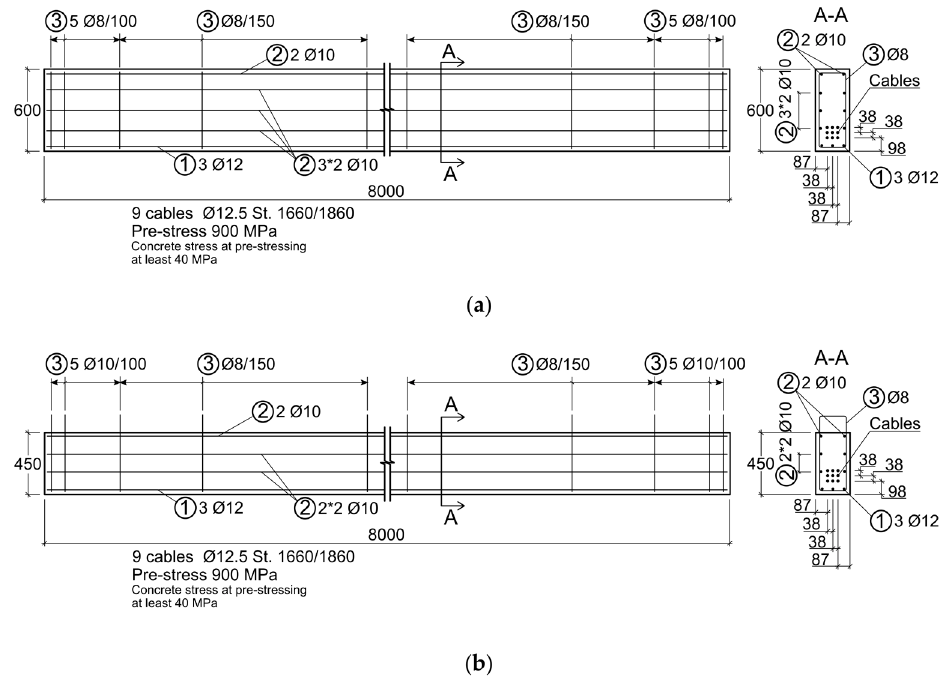
Figure 1. Reinforcement scheme of the tested beams: ( a ) pre-stressed single-layer beam; ( b ) pre-stressed two-layer beam. Table 2. Experimental values of SFHSC